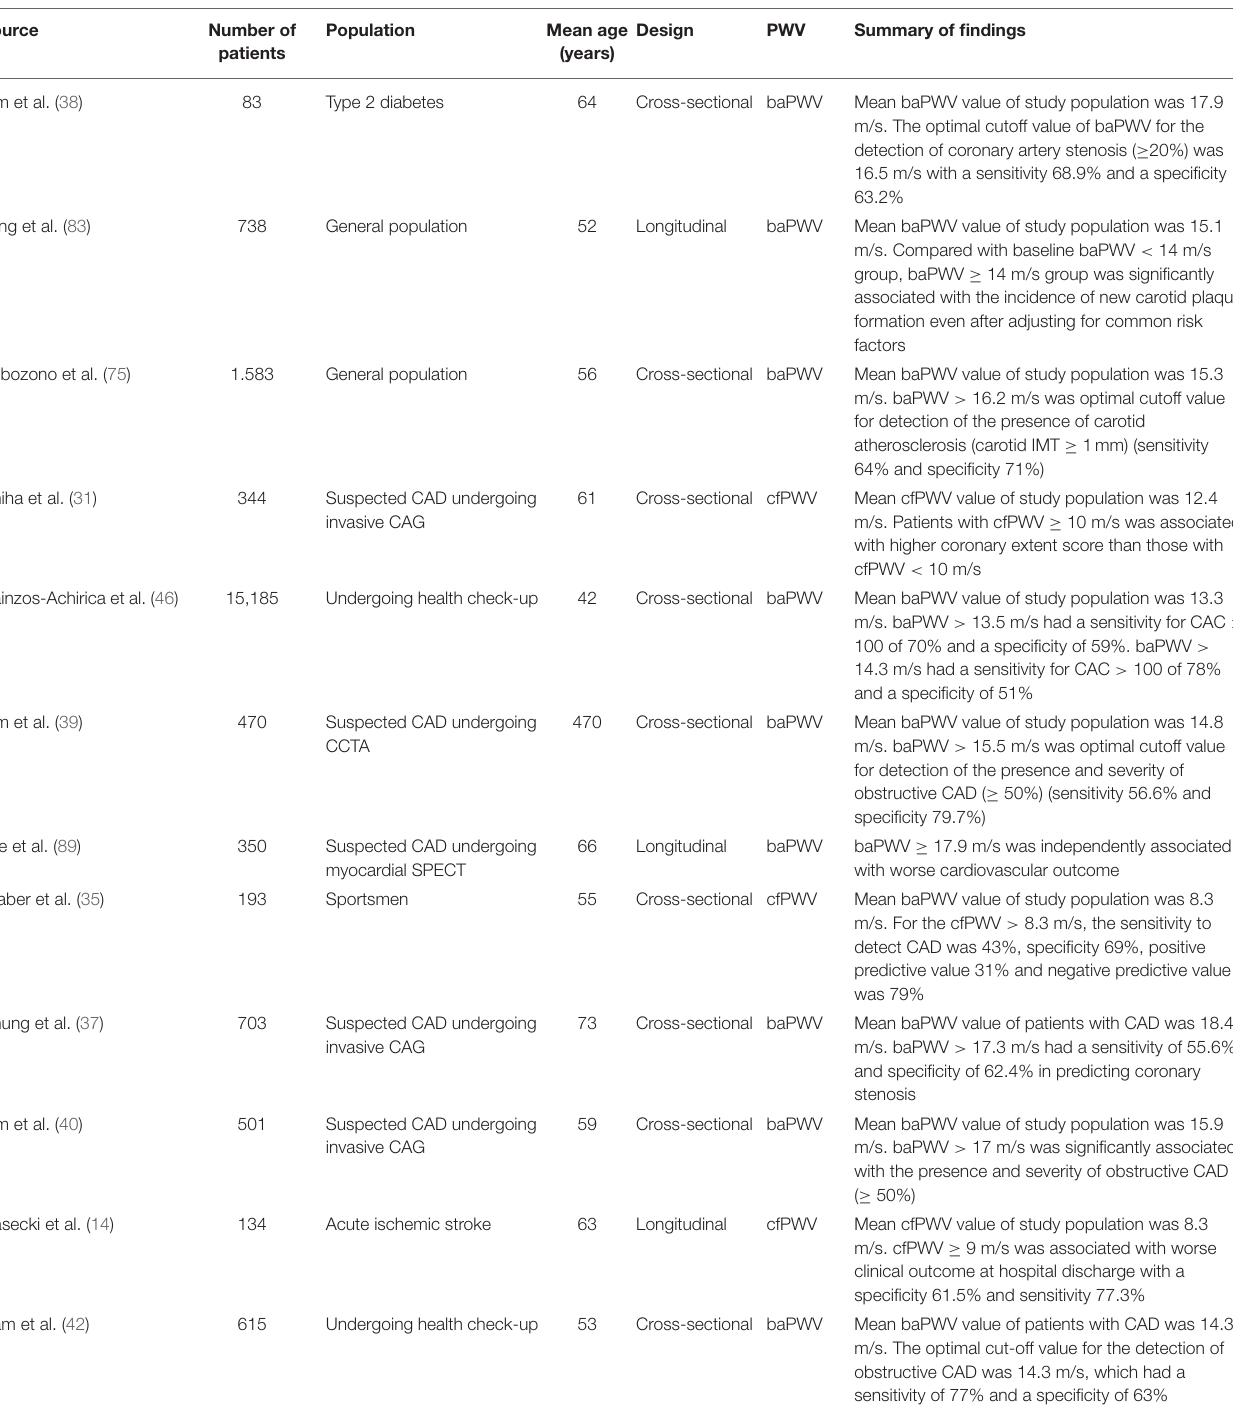
TABLE 4 | Summary of recent studies showing cut-off value of PWV in the prediction of atherosclerosis or future cardiovascular